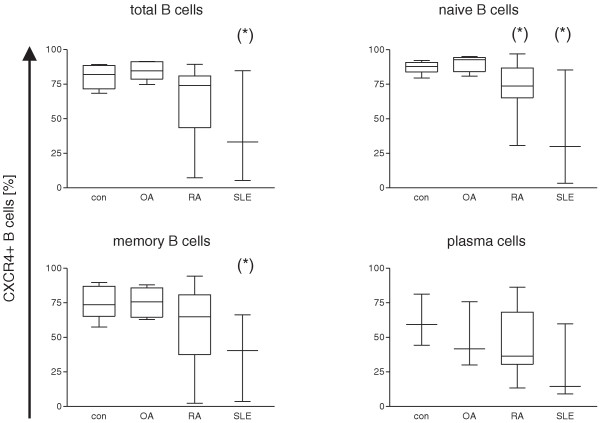
Chemokine receptor CXCR4+ expression on B cell subpopulations. The percentage of total B cells, naive B cells, memory B cells and plasma cells expressing CXCR4+ are given. Box plots show the median values, 25th and 75th quartile and the range of values. Significant differences from controls are shown (*P < 0.05).